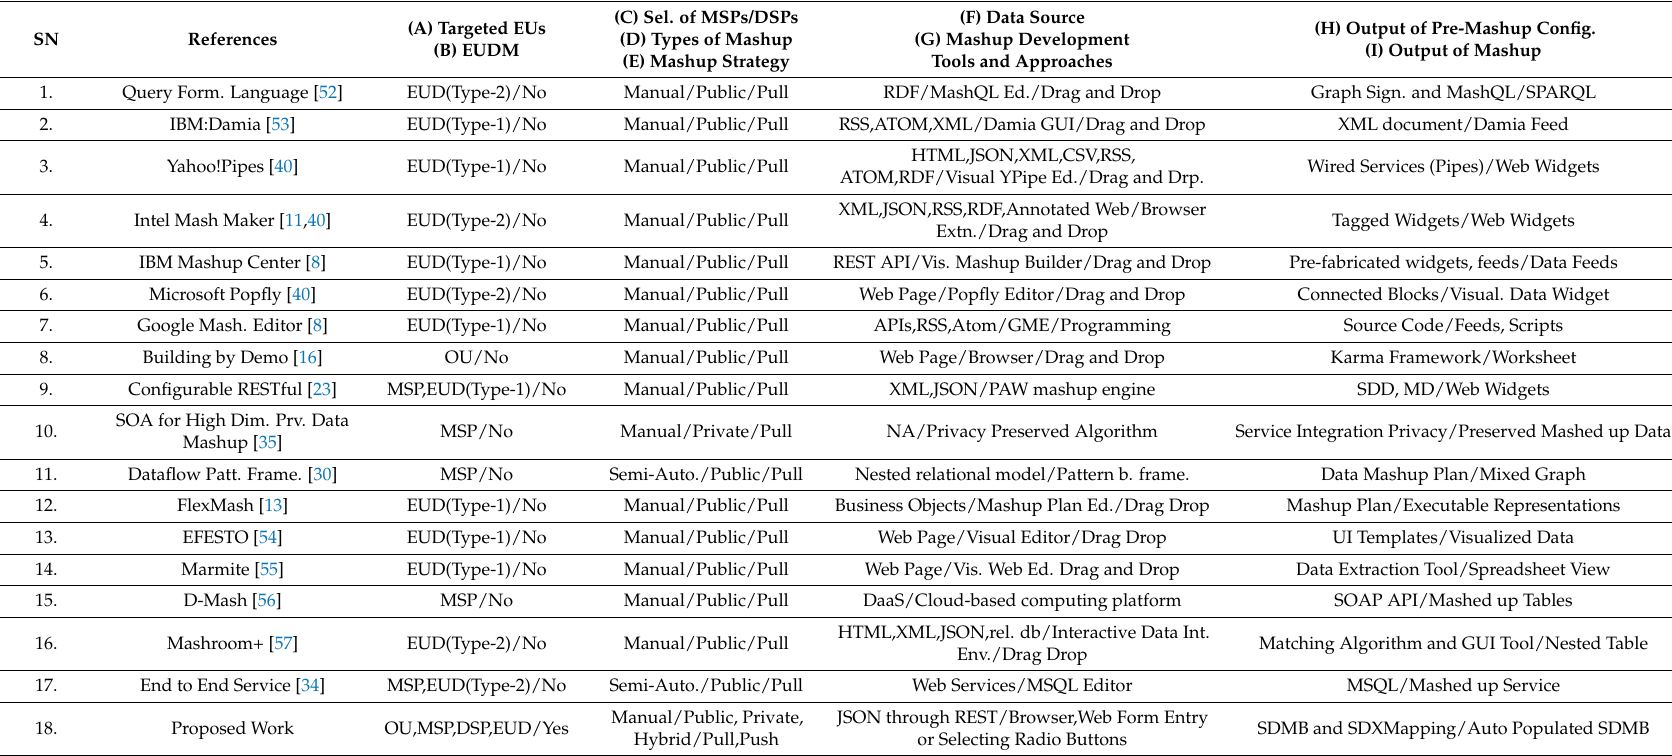
Table 10. The Comparisons of mashup tools, techniques and